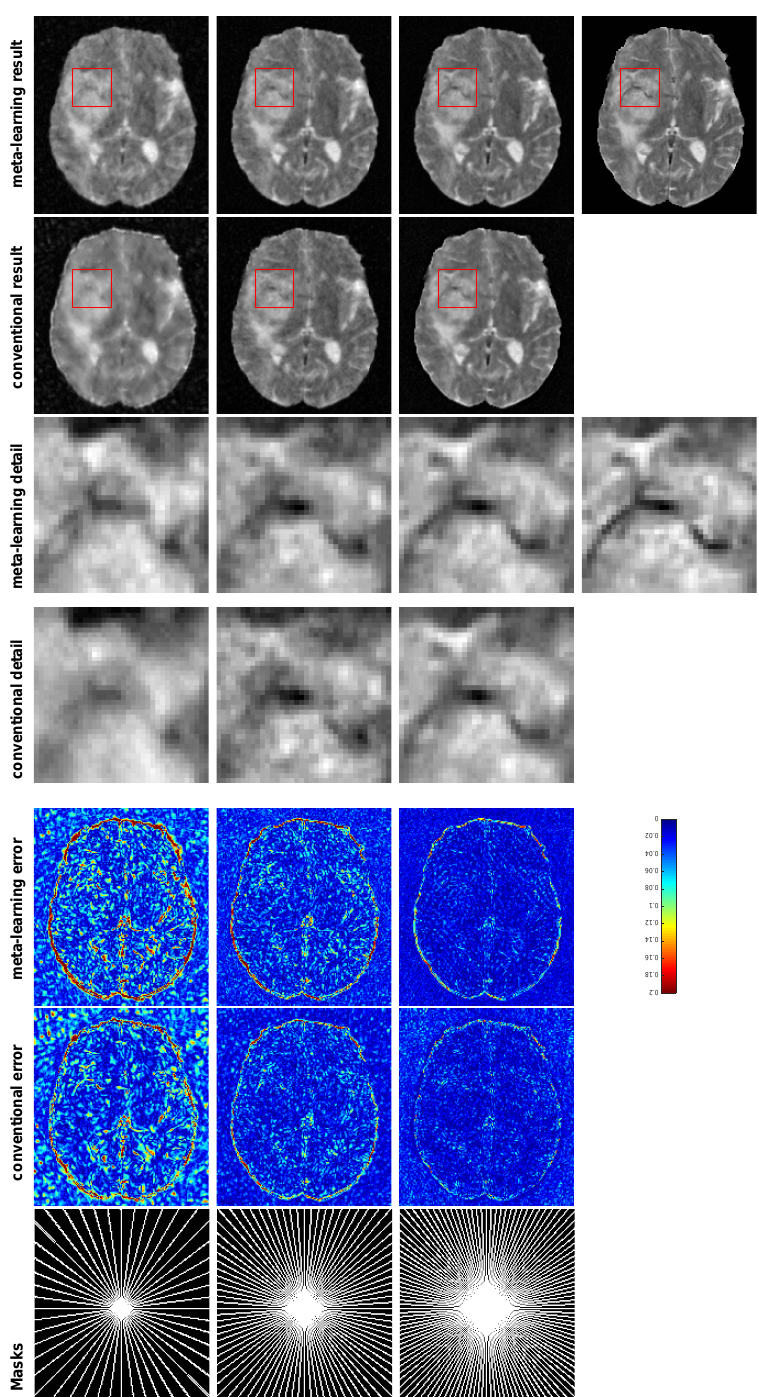
Figure 4. The pictures (from top to bottom) display the T2 brain image reconstruction results, zoomed-in details, point-wise errors with a color bar, and associated radial masks for meta-learning and conventional learning. Meta-learning was trained with CS ratios of 10%, 20%, 30%, and 40% and test edwith three different unseen CS ratios of 15%, 25%, and 35% (from left to right). Conventional learning was trained and tested with the same CS ratios of 15%, 25%, and 35%. The top-right image is the ground truth fully-sampled